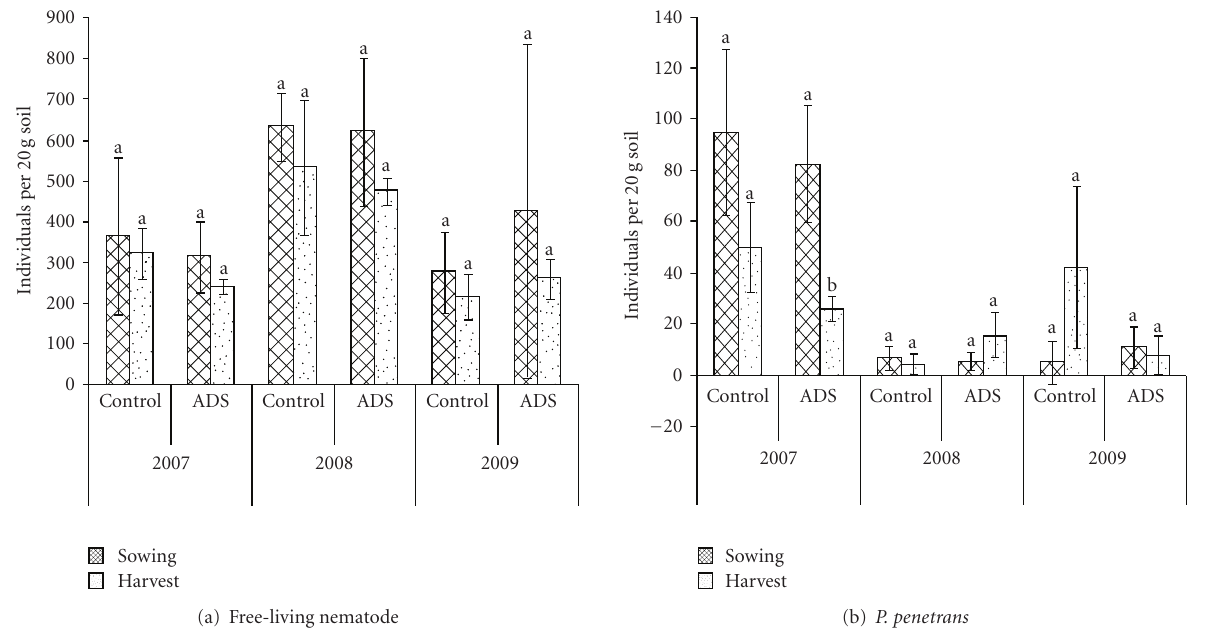
Figure 2: Populations of free-living nematodes (a) and Pratylenchus penetrans (b) at sowing and harvest in radish cultivated fields applied with anaerobically digested slurry. Error bars indicate standard deviation, and the di ff erent letters indicate significant di ff erence ( P < . 05) between at sowing and at harvest.